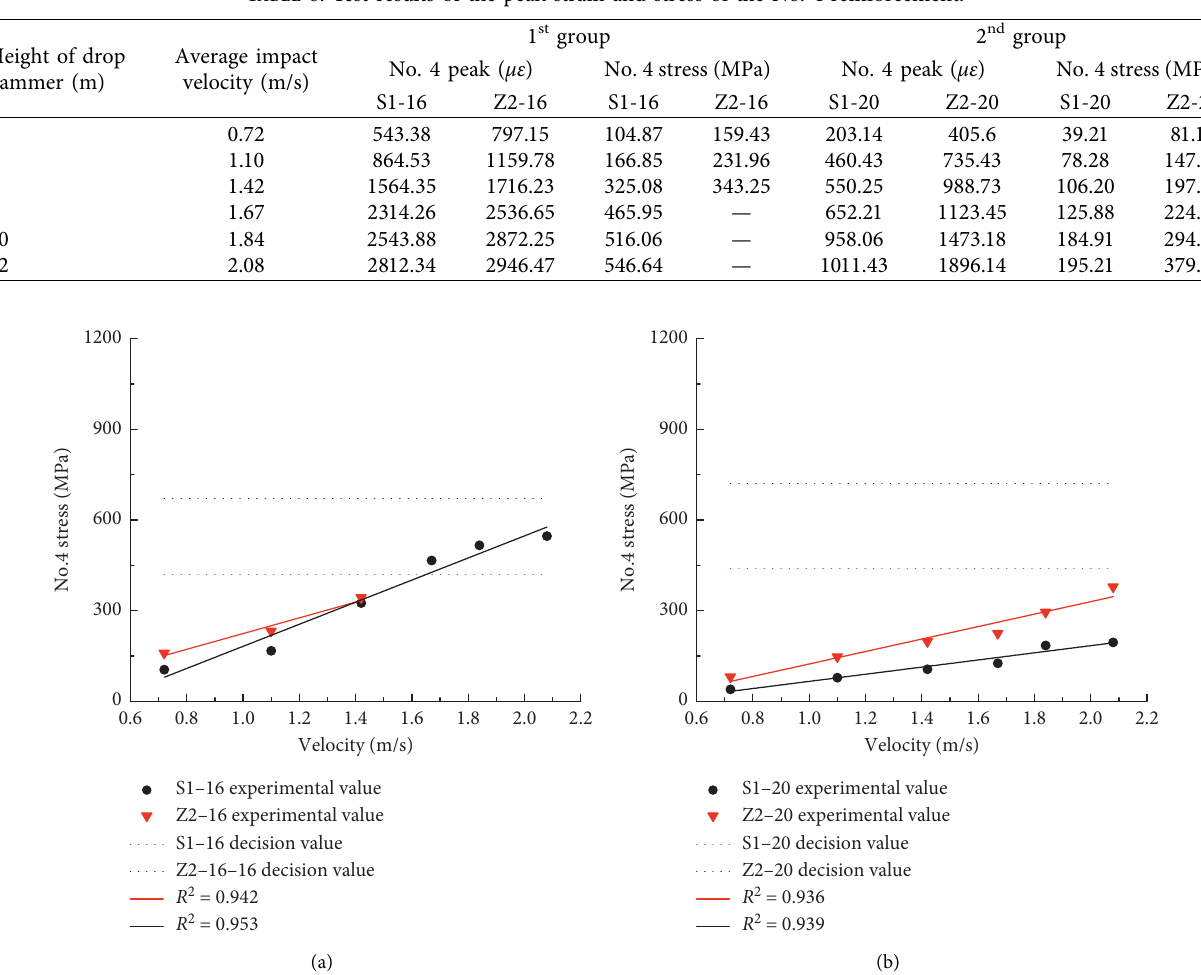
Figure 16: Fitting of the stress and impact velocity values of the No. 4 reinforcements. In the figure, diameter 16 is 50 mm closed-cell aluminum foam and diameter 20 is 100mm closed-cell aluminum foam; when the Z2-16 reinforcement reached the yield stage at 1.2m/s, its elastic modulus could not be determined, and only the first two three values were